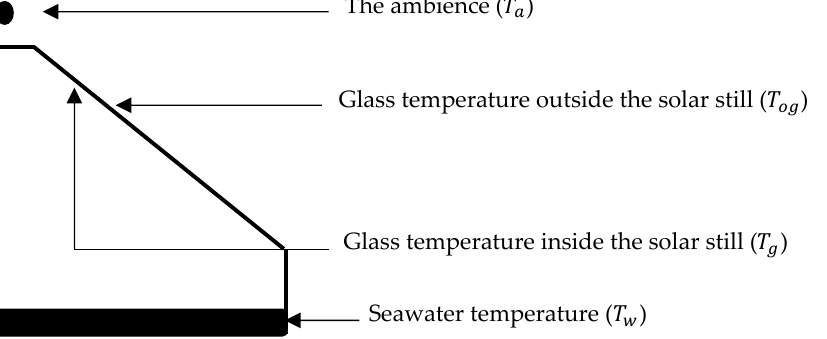
Figure 10. Location of the temperatures measured for the solar still tests. The location of the places where the temperature readings were taken using the thermocouples T w and T g and the laser thermometer T og and T a are shown.